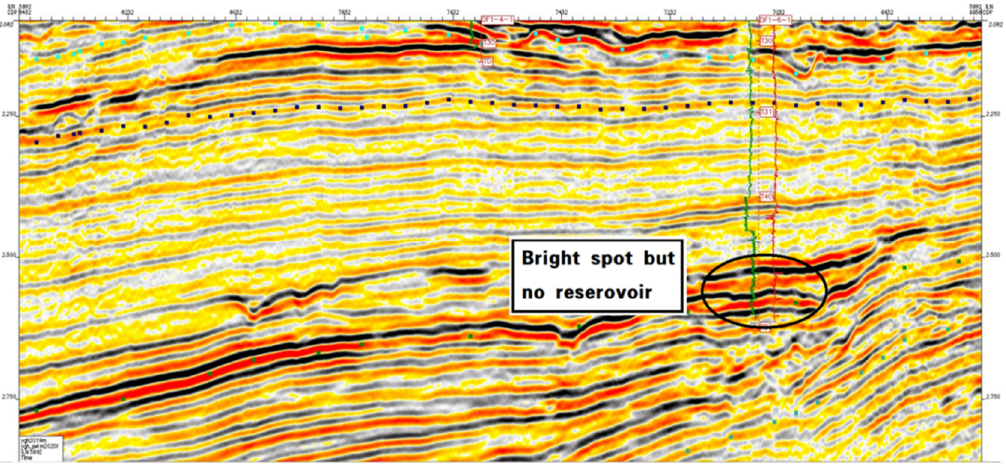
Figure 1. Seismic profile through the DF1-X6 well.